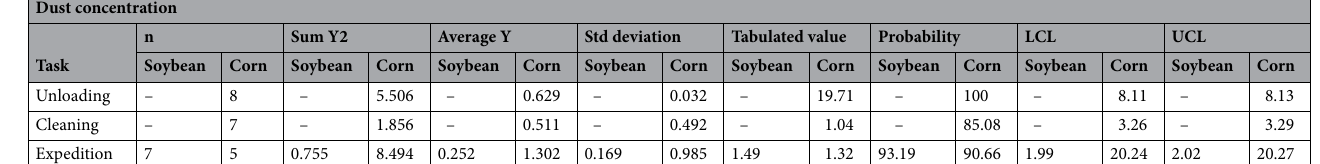
Table 4. Total dust measurement at unloading (U), cleaning (C1 one machine; C2 two machines) and expedition (E) postharvest pre-processing operations. Where: LCL = Lower Confidence Limit; UCL = Upper Confidence